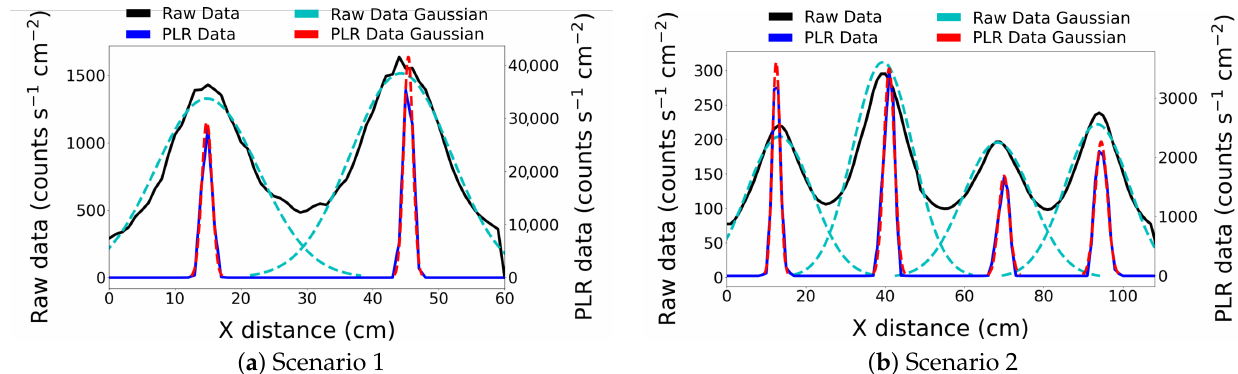
Figure 7. ( a ) Scenario 1 and ( b ) Scenario 2. Comparison of 1D transects through the interpolated raw measurements (Raw Data) against the best solution estimated by the linear reconstruction technique (PLR data). Best fit Gaussian distributions have been fitted to both to enable a quantitative resolution assessment to be